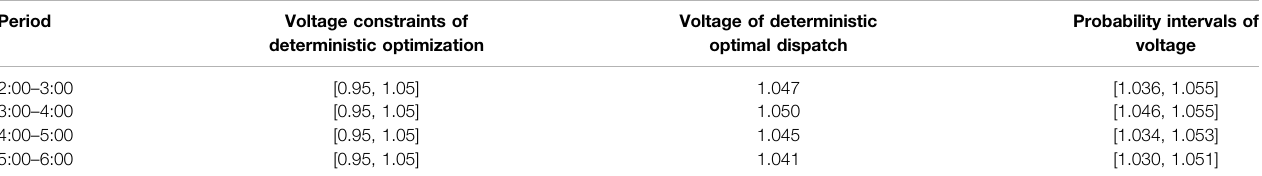
TABLE 2 | Variables that do not satisfy the chance constraint of 32-node in fi rst iteration.